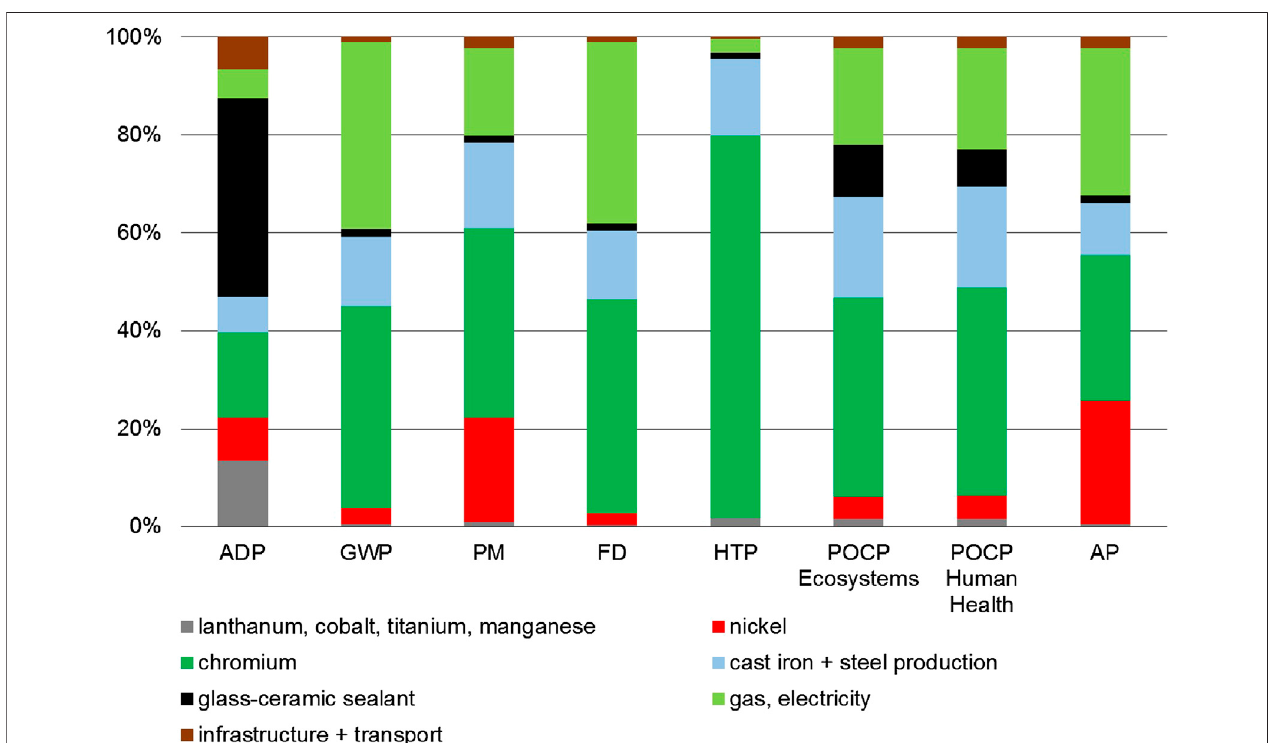
FIGURE 8 | Share of stack materials, energy demand and others on the total environmental impacts of the stack construction for HT-co-electrolysis.